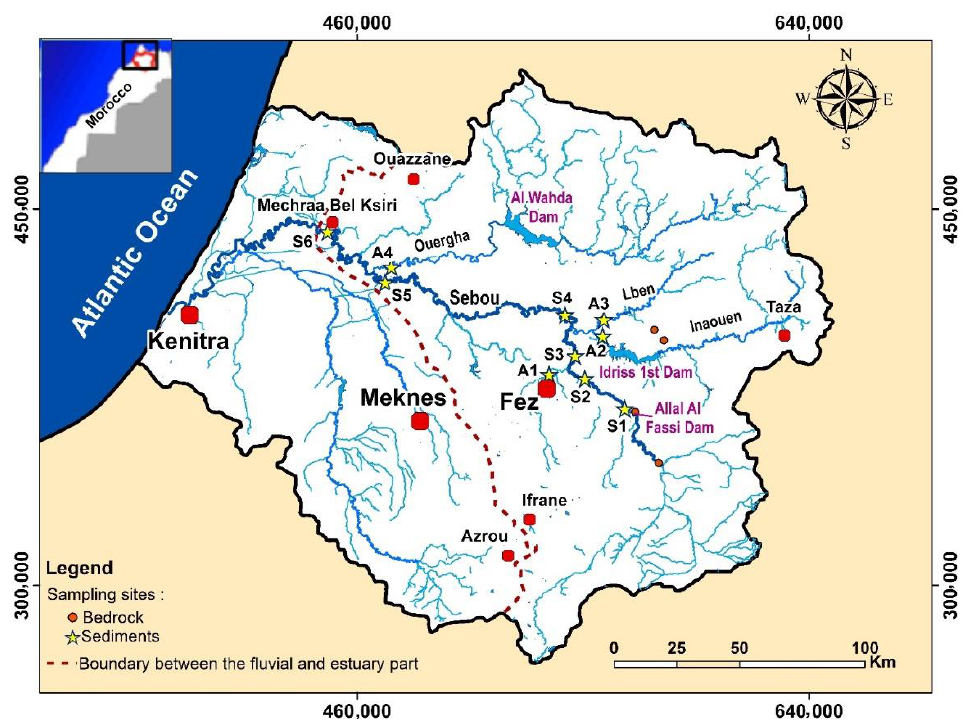
Figure 1. The Sebou basin (North-West Morocco) and the location of the bedrock and bottom sediments sampling stations from upstream to downstream: along the Sebou main course (from S1 to S6) and the tributaries (from A1 to A4). The red dashed line delimits the considered fluvial sub-basin at Machraa Bel Ksiri city (outlet station S6). For maps concerning geology-lithology, land cover, and anthropic activities, see SM Figures S1 and S2.